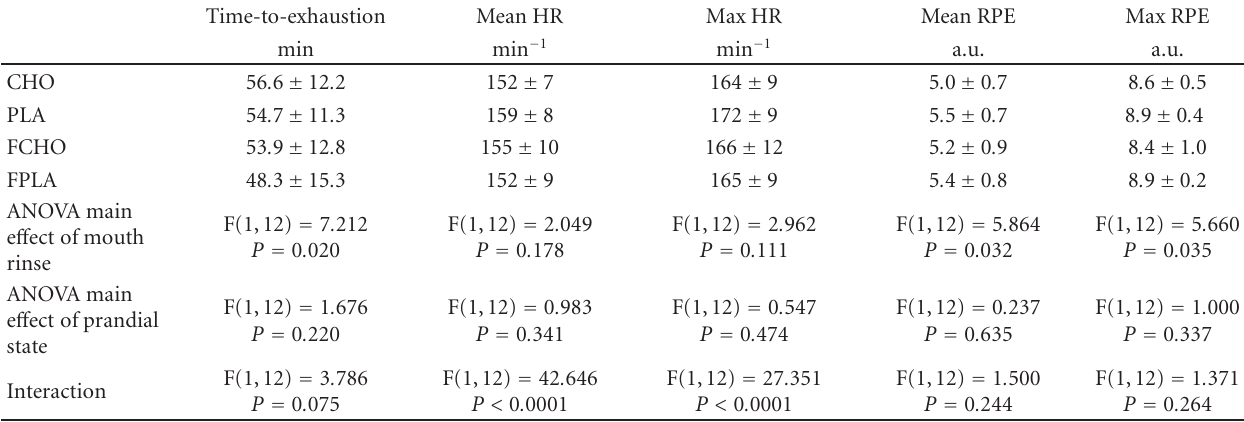
Table 1: Average values for time-to-exhaustion, heart rate, and RPE in the four conditions.